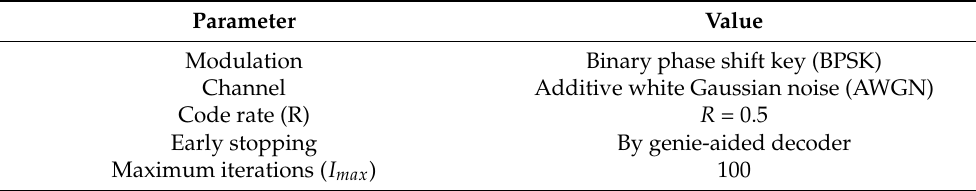
Table 1. Configuration for the Monte Carlo simulation with 10 7